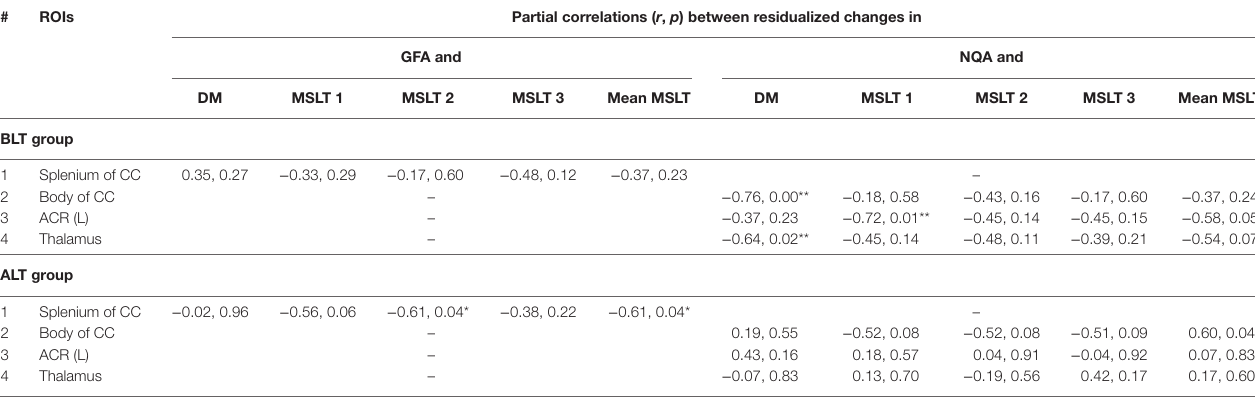
ROIs, regions of interest; GFA, generalized fractional anisotropy; NQA, normalized quantitative anisotropy; DM, delayed memory; MSLT, multiple sleep latency test; BLT, blue-light therapy; CC, corpus callosum; ACR (L), anterior corona radiata (left); ALT, amber-light therapy; FDR, false discovery